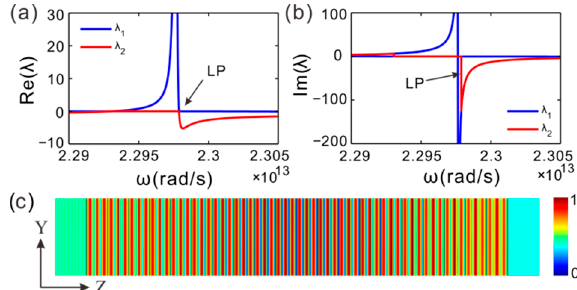
Figure 4. ( a , b ) The real part and imaginary part of eigenvalues for scattering matrix varying with the angular frequency around the LP for q = q LP . ( c ) The electric field intensity (| E z | 2 ) distribution at the